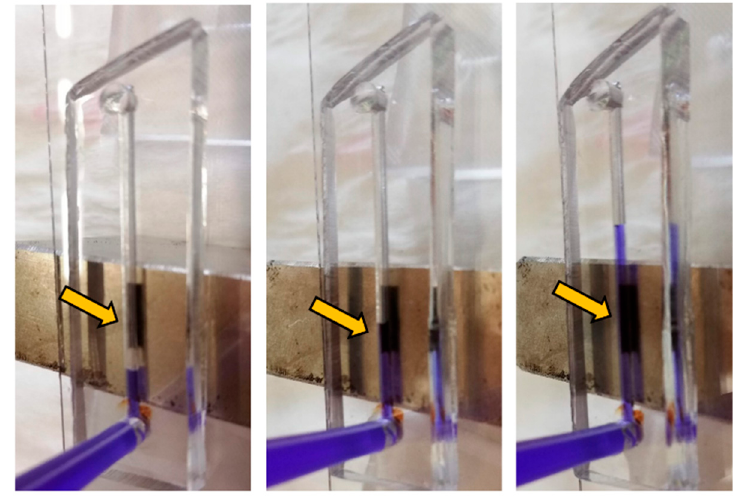
Figure 2. Example of the capture of microparticles; the arrow indicates microparticles.